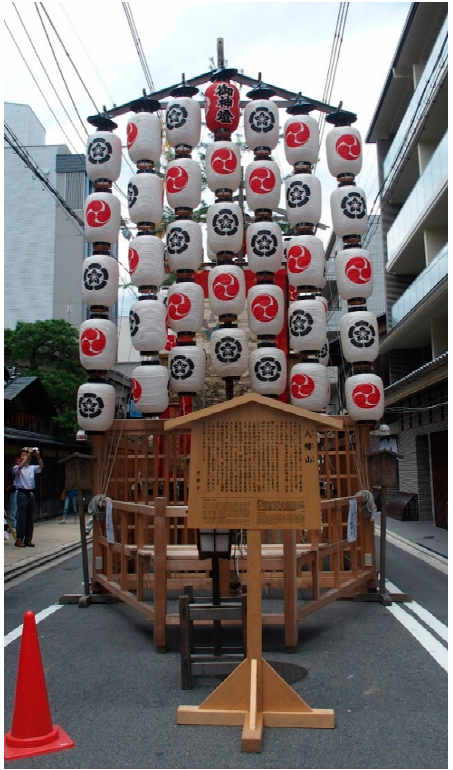
Figure A1. The Hachiman-Yama float in the Gion Festival.